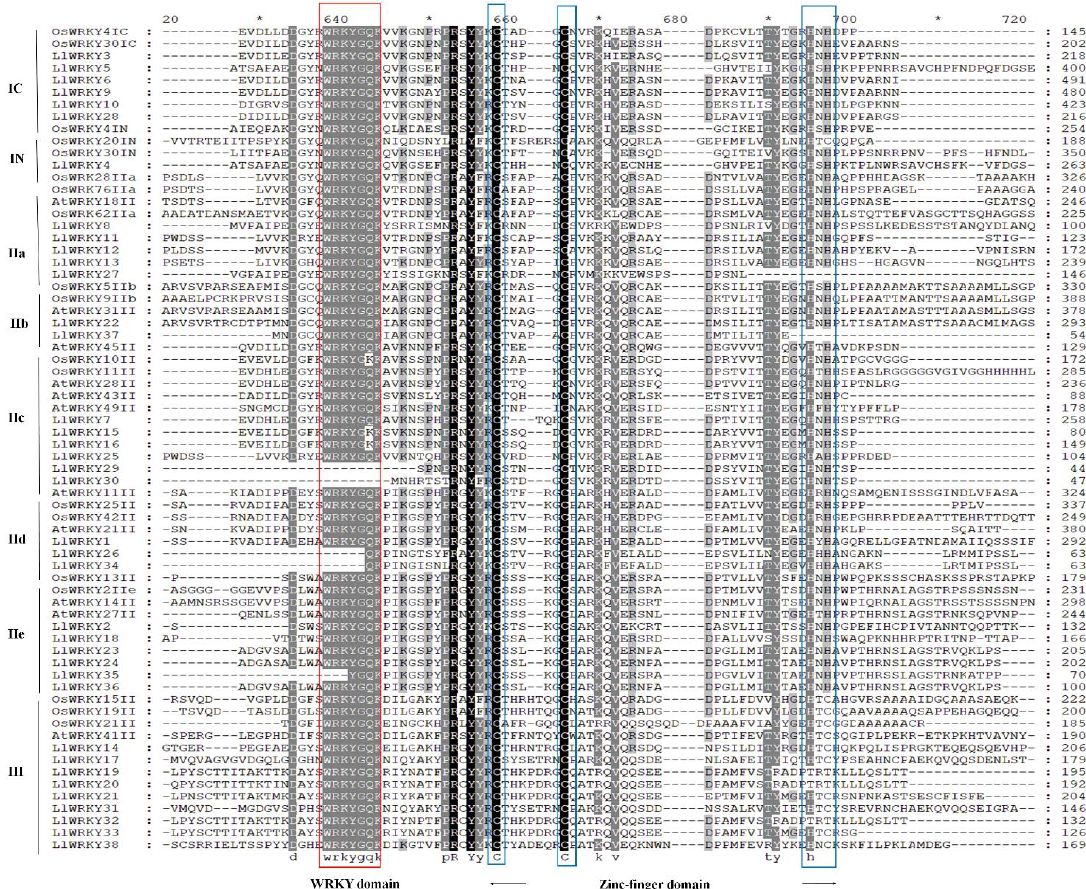
Figure 1. Multiple sequence alignment of various types of WRKY domains (I, II, and III) from Lillium ( LlWRKY ), Arabidopsis ( AtWRKY ), and rice ( OsWRKY ). Identity, similarity, and deletions among WRKY alignments are indicated by black and grey shades and hyphens, respectively. A red box represents the WRKY domain and a blue box the zinc finger domain. N means N-terminal and C means C-terminal.